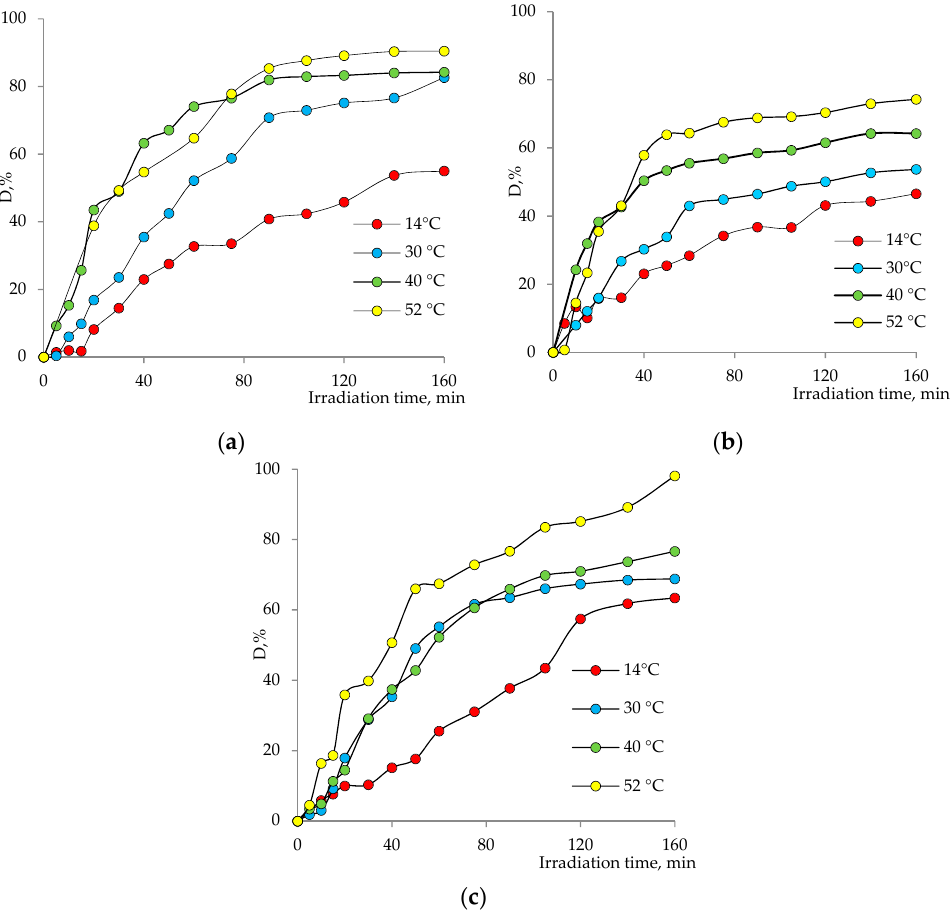
Figure 10. Variation in Czm degradation degree with irradiation time at different temperatures in the presence of ( a ) ZnO@PET, ( b ) Cu 2 O@PET and ( c ) Cu 2 O/ZnO@PET composite membranes. The activation energy E A was calculated using the Arrhenius equation (Equation (5)) and determined graphically from the relation ln k a -(1000/T) (Figure 11):